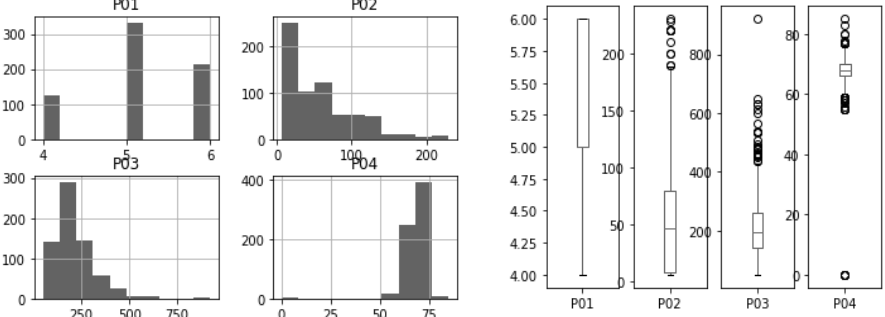
Figure 7. Histogram and range of the parameters considered in the second approach.